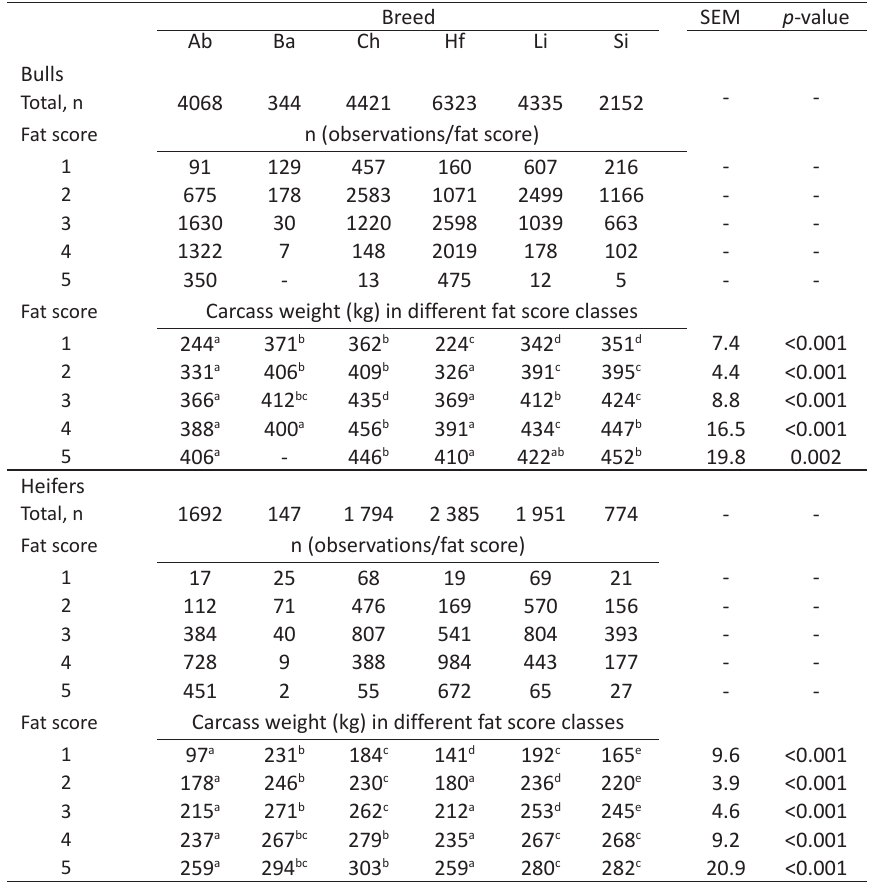
Table 4. Average carcass weights of Aberdeen Angus (Ab), Blonde d’Aquitaine (Ba), Charolais (Ch), Hereford (Hf), Limousin (Li) and Simmental (Si) bulls and heifers in different EUROP fat score classes (1 = leanest, 5 = fattest). Between-breeds comparisons (Tukey, p <0.05): estimated means with the different letters were significantly different ( p <0.05).